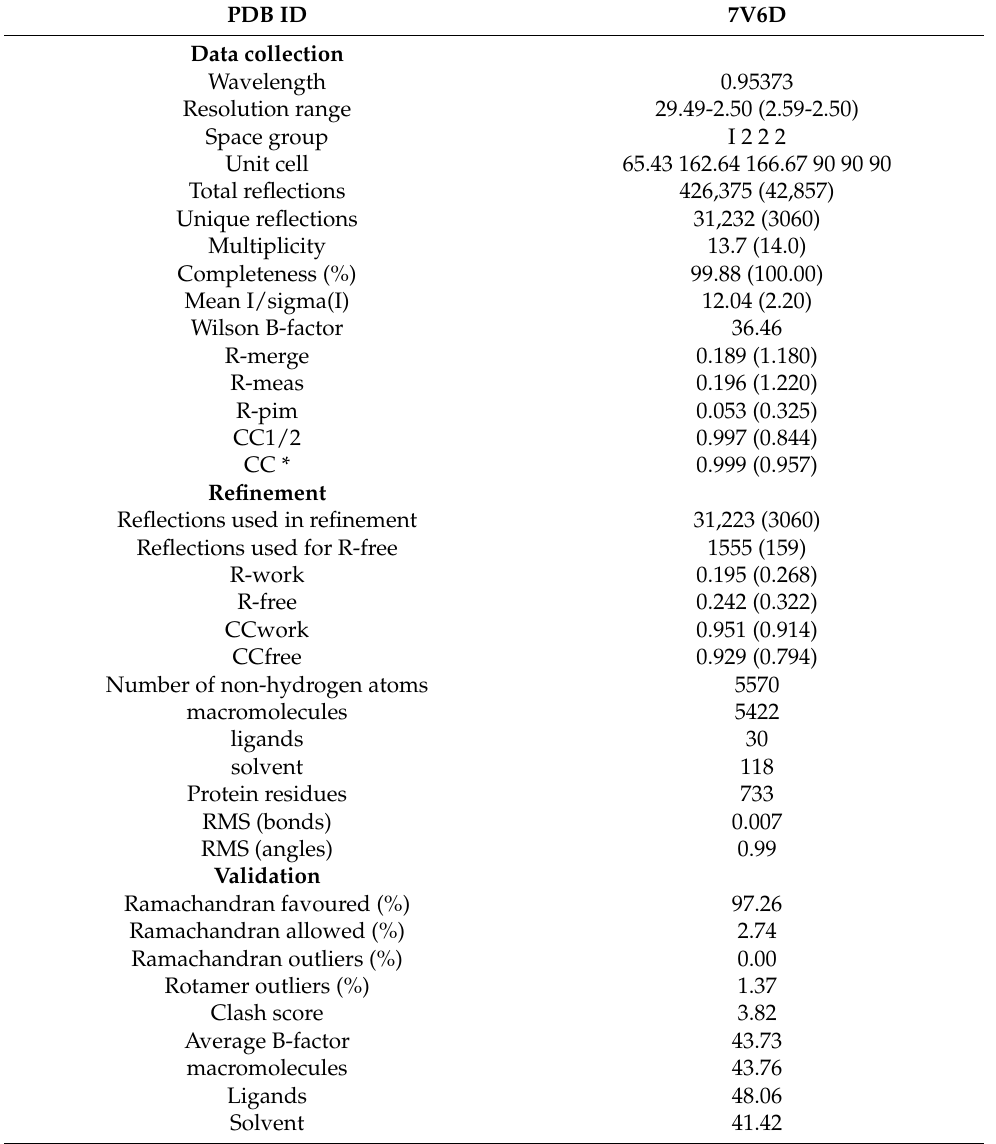
Table 2. X-ray crystallographic data collection, refinement, and validation